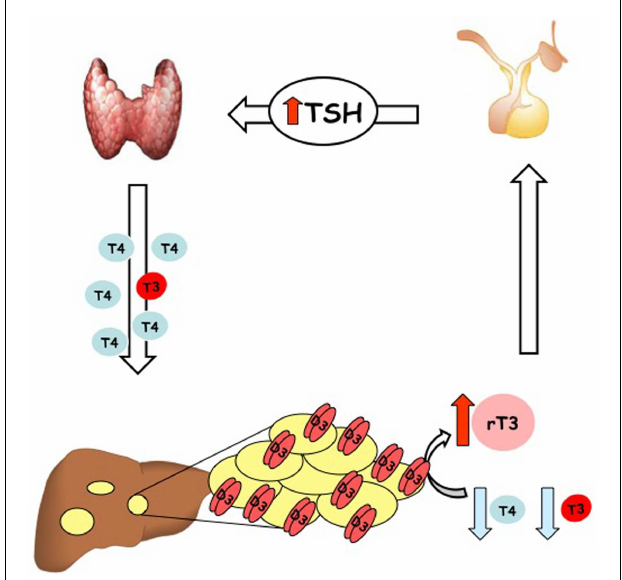
FIGURE 1 | Schematic illustration of the pathogenesis of condition named “consumptive hypothyroidism.”